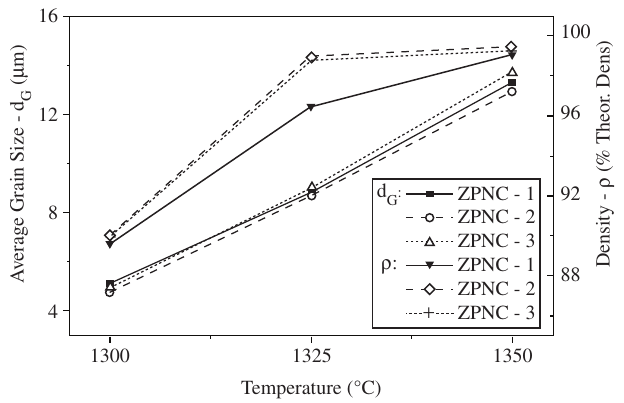
Figure 1. Average Grain Size and Relative Density (in percentage of the theoretical density) of ZPNC varistor ceramics as a function of the sintering temperature.